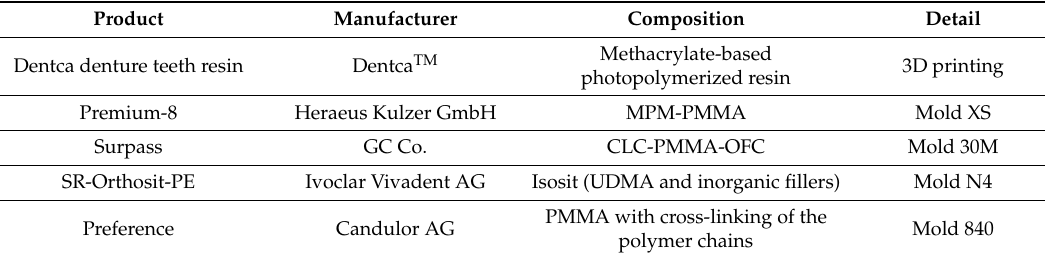
Table 1. Resin denture artificial teeth investigated in this study.*